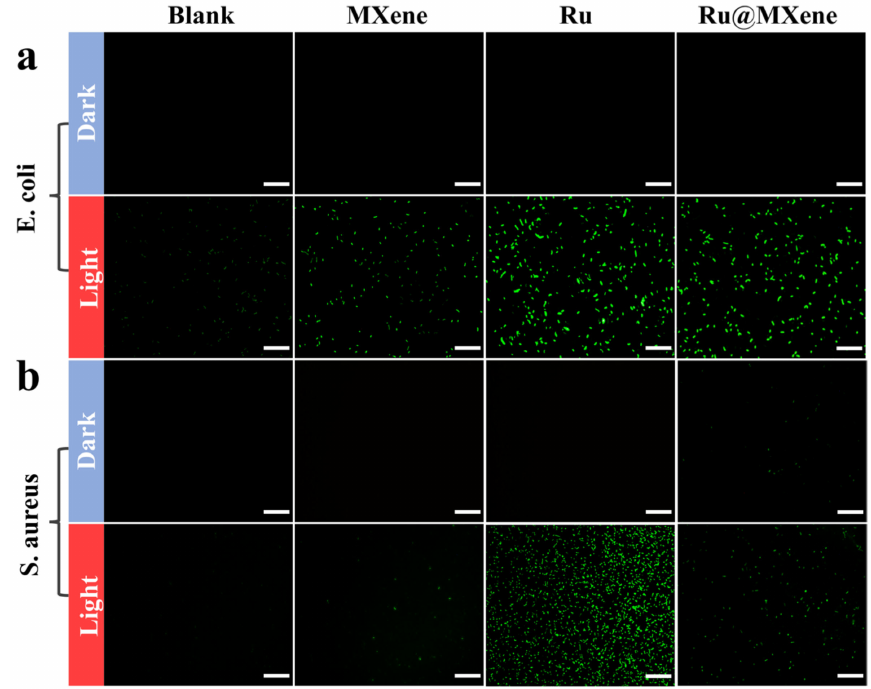
Figure 10. Antibacterial mechanism evaluations involving intracellular ROS level detection: Fluo- rescence intensity of intracellular ROS induced by different samples with or without xenon lamp illumination (150 mW/cm 2 , 30 min) in ( a ) E. coli and ( b ) S. aureus . (Scale bar: 50 µ